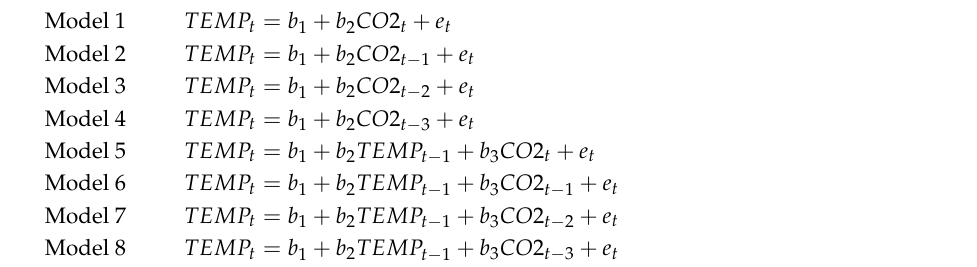
Table 1. Models under